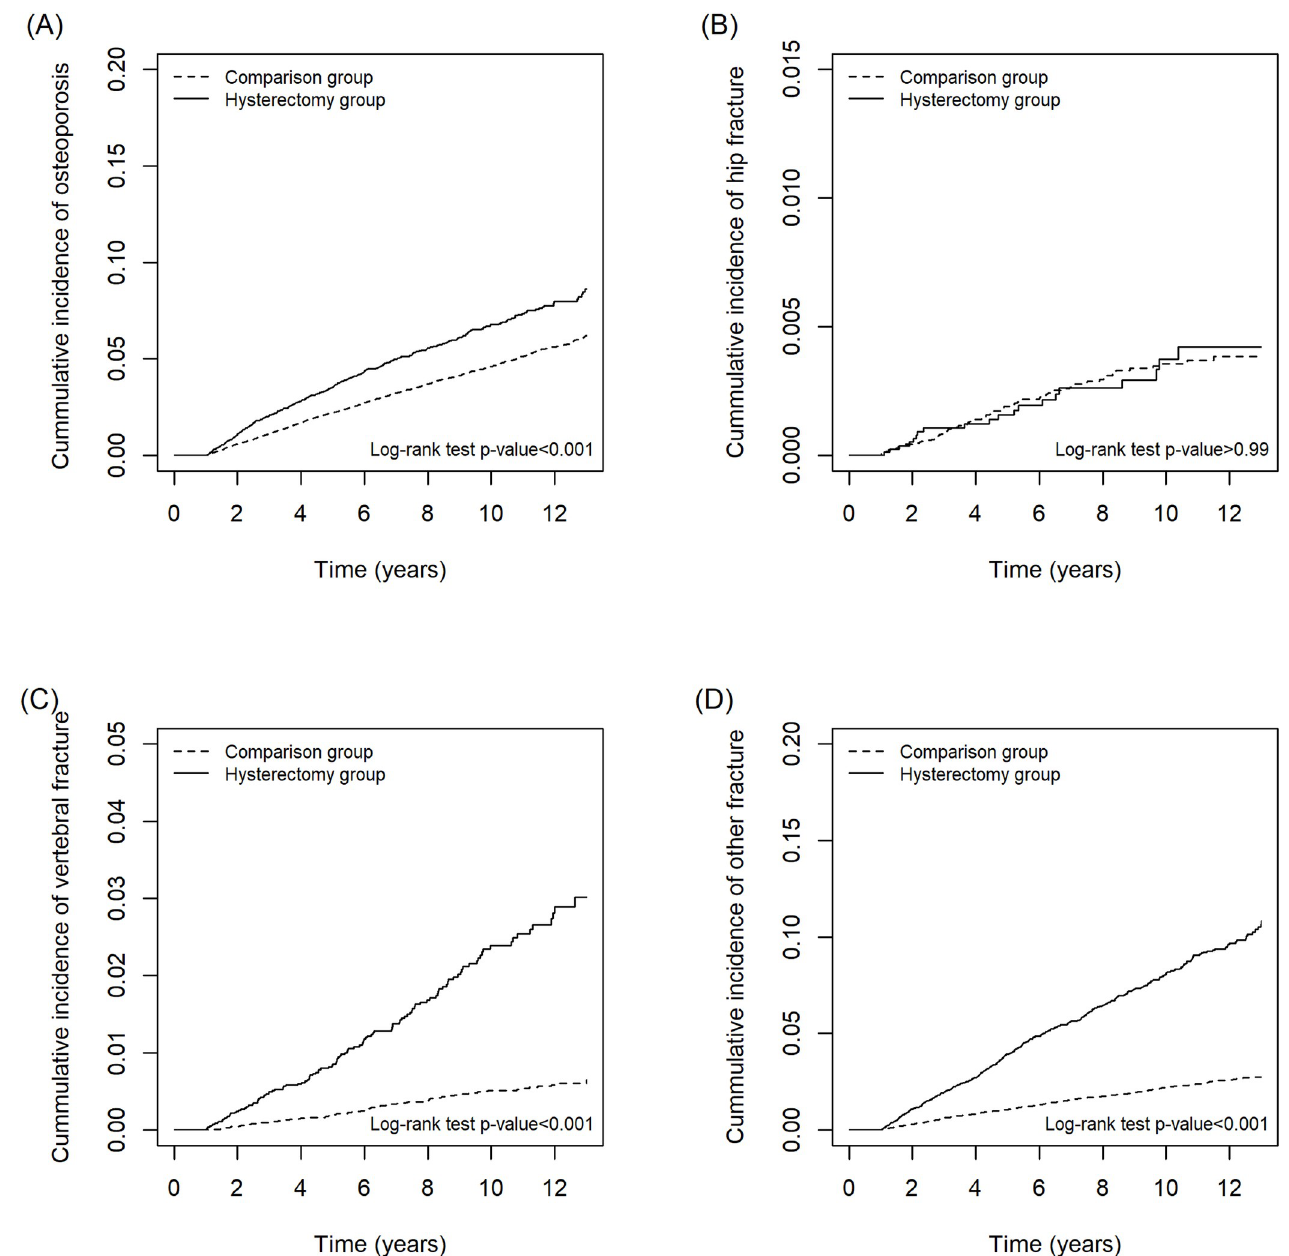
Fig 2. Kaplan–Meier curves showing the cumulative incidence of (A) osteoporosis, (B) hip fracture, (C) vertebral fracture, and (D) other fracture in women receiving hysterectomy (dashed line) compared with the age- and comorbidity-matched comparison group (solid line).